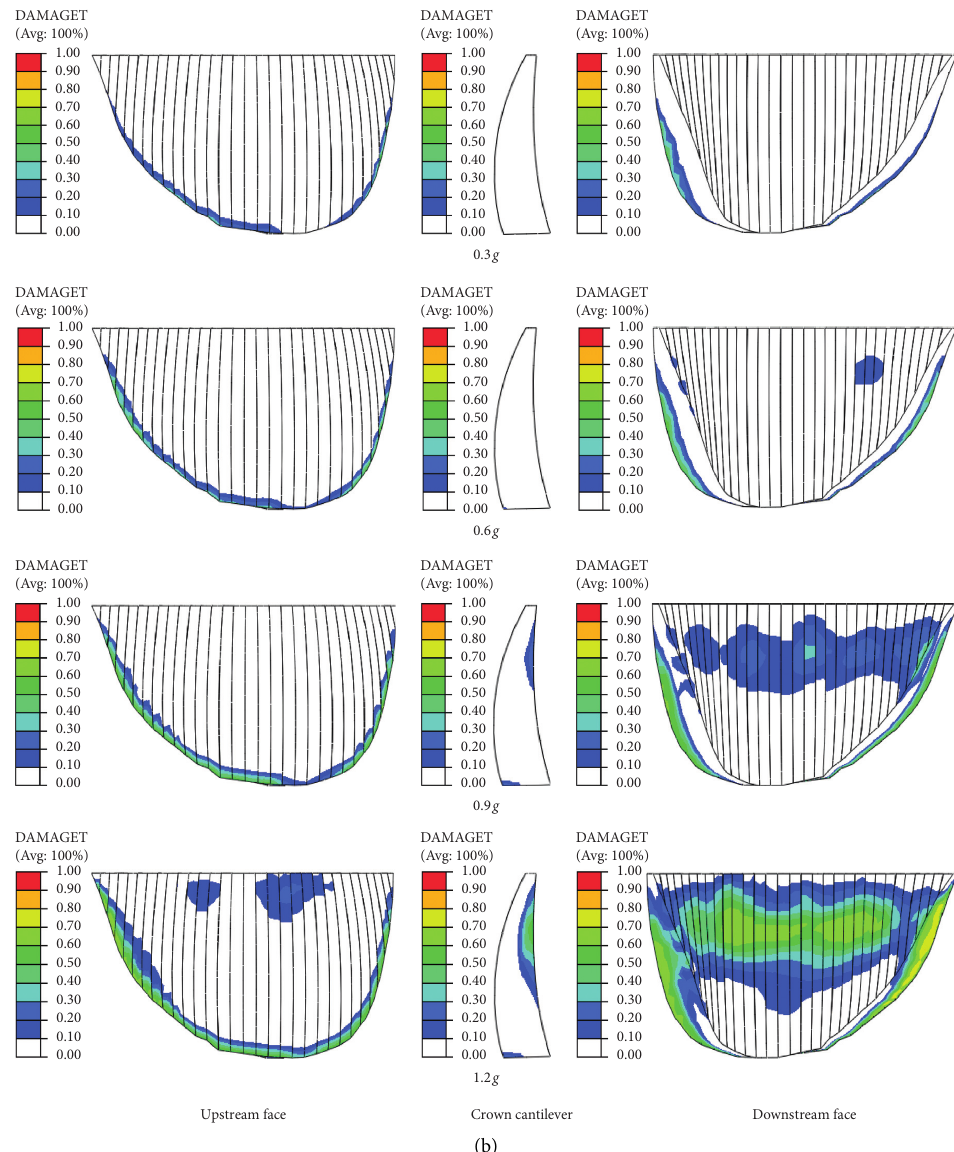
Figure 11: Damage distributions under typical PGAs for two cases of ETAH: (a) case no. 1; (b) case no.